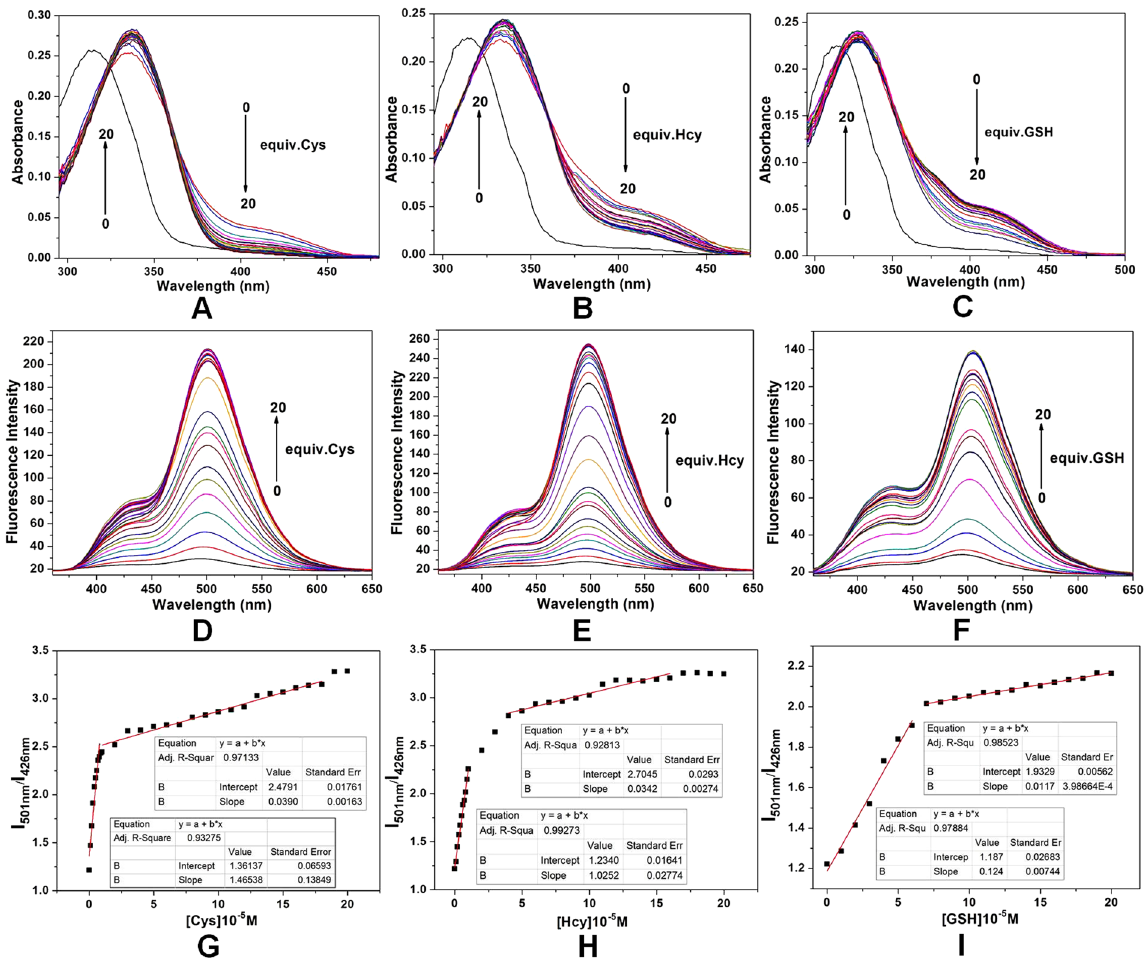
Figure 8. ( A – C ) UV-Vis absorption spectra of NL-AC (10 μ M) with Cys/Hcy/GSH (0, 0.1, 0.2, 0.3, 0.4, 0.5, 0.6, 0.7, 0.8, 0.9, 1, 2, 3, 4, 5, 6, 7, 8, 9, 10, 11, 12, 13, 14, 15, 16, 17, 18, 19 and 20 equiv.) in HEPES buffer solution (DMSO/HEPES = 8:2, pH 7.4); ( D – F ) Fluorescence spectra of NL-AC (10 μ M) with Cys/Hcy/GSH (0, 0.1, 0.2, 0.3, 0.4, 0.5, 0.6, 0.7, 0.8, 0.9, 1, 2, 3, 4, 5, 6, 7, 8, 9, 10, 11, 12, 13, 14, 15, 16, 17, 18, 19 and 20 equiv.) in HEPES buffer solution (DMSO/HEPES = 8:2, pH 7.4, λ ex = 336 nm, slit: 5.0 nm/5.0 nm); ( G – I ) A plot of the ratiometric response (I 501 /I 426 ) of NL-AC (10 μ M) against Cys/Hcy/GSH equiv. is shown; the data represent means ± standard error (bars) (n =